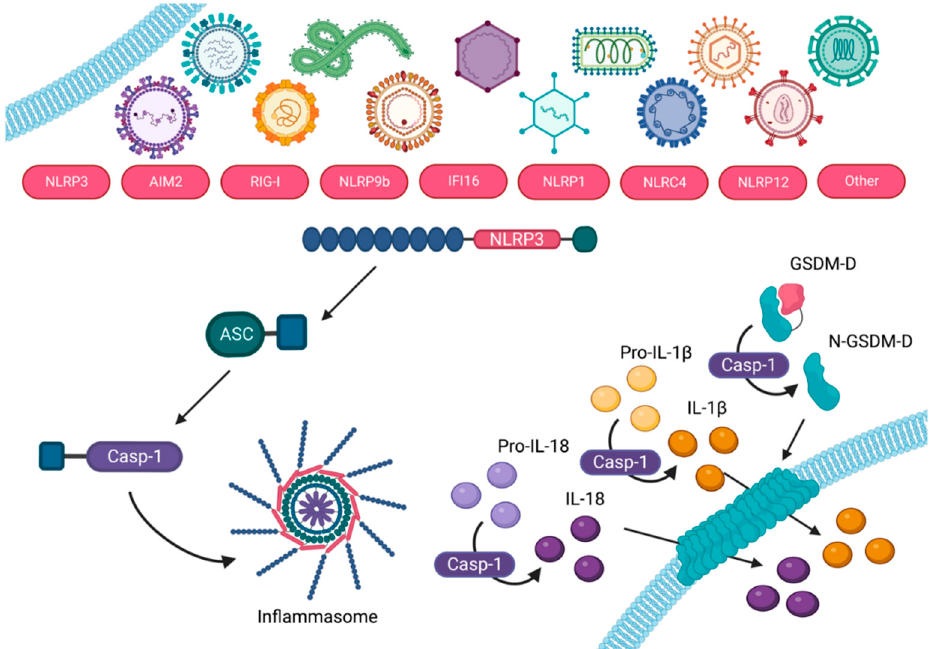
Figure 1. Virus-induced inflammasome pathway which ultimately results in pyroptosis. Numerous viruses can activate various inflammasome sensors such as NLRP3, AIM2. RIG-I, NLRP9b, IFI16, NLRP1, NLRC4, NLRP12, and/or others, directly or indirectly. The activated sensor then oligomerizes with ASC (if it does not contain its own CARD). Caspase-1 is then recruited to the inflammasome to act as the effector enzyme. Caspase-1 cleaves GSDM-D and the N-terminus migrates to the cellular membrane to form pores. At the same time, pro-IL-18 and pro-IL-1 β are also cleaved by caspase-1 into their mature forms, and subsequently released through the pores formed by GSDM-D. This figure was created with BioRender.com and adapted from Jorgensen et al. [28].